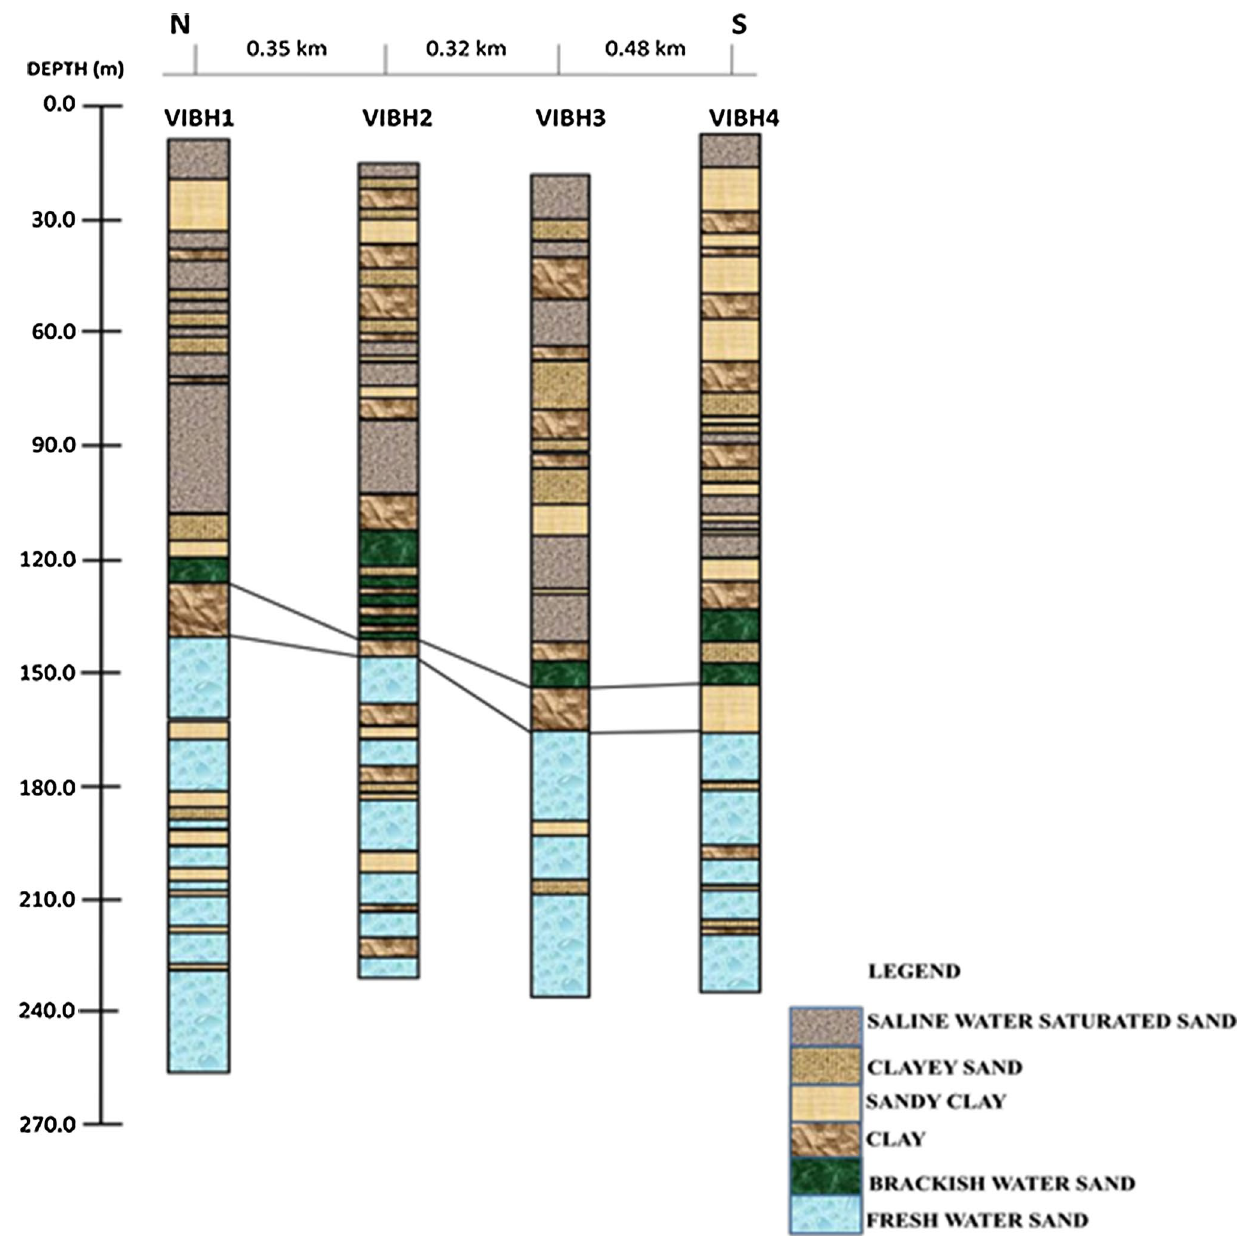
Fig. 4 Correlation panel of geosection A–A ′ showing the occurrence of the end of polluted sand unit and the beginning of freshwater sand